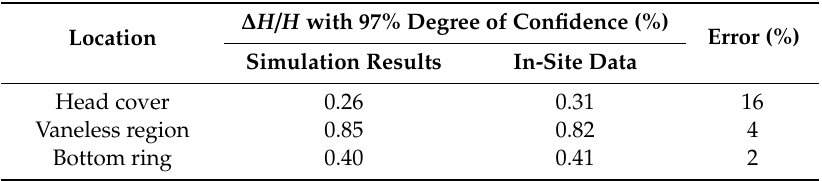
Table 1. ∆ H / H with 97% confidence at di ff erent positions for simulation and in-site data. Table 1. Δ H / H with 97% confidence at different positions for simulation and in-site data.